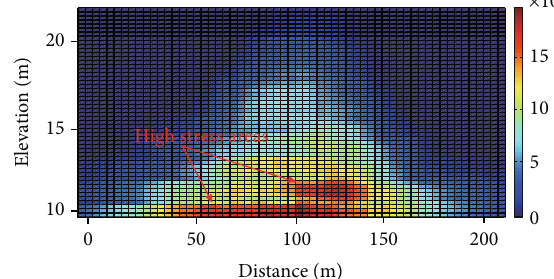
Figure 10: The normal stress distribution on rigid retaining wall in stable state (Pa).